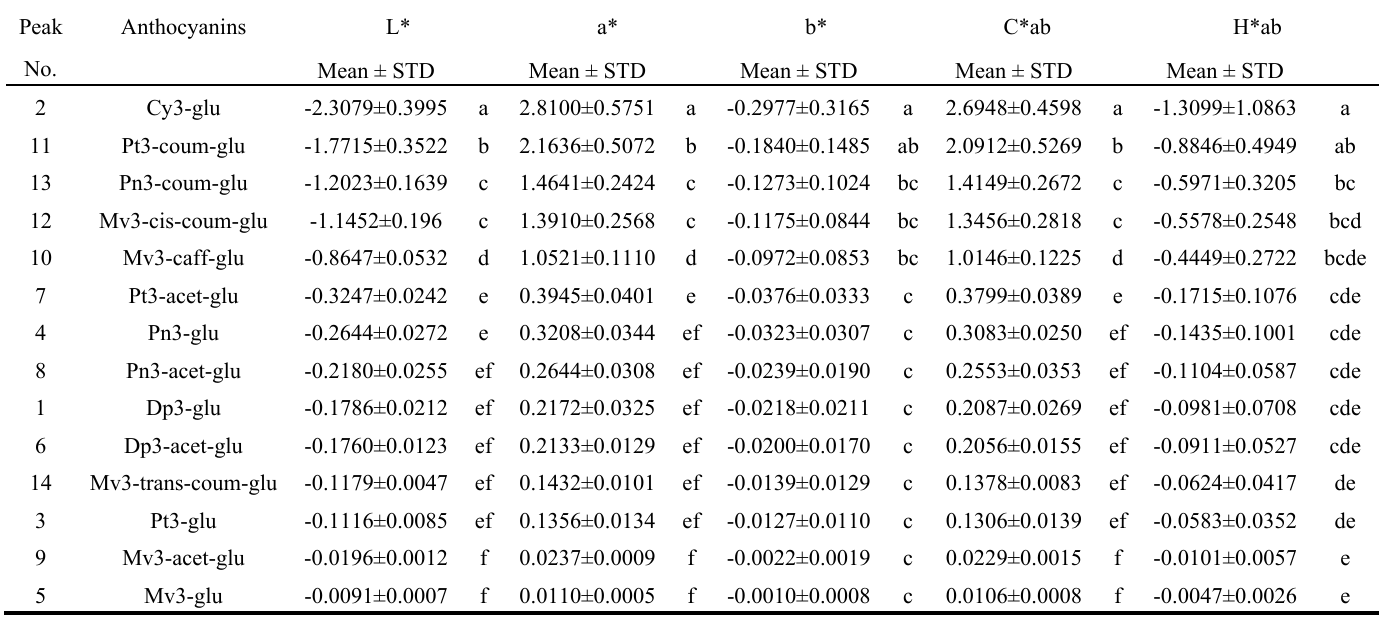
Table 3 . The color values of various anthocyanins estimated by